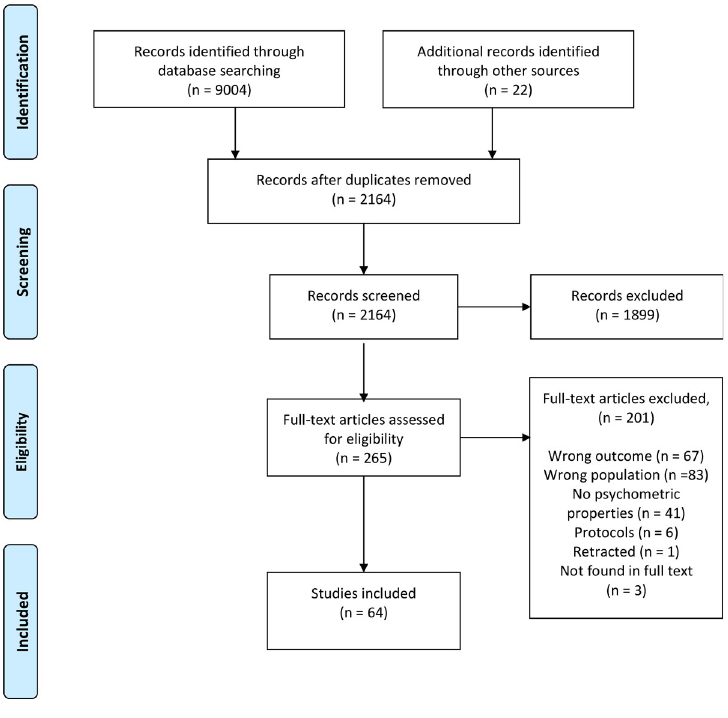
Fig 1. PRISMA flow